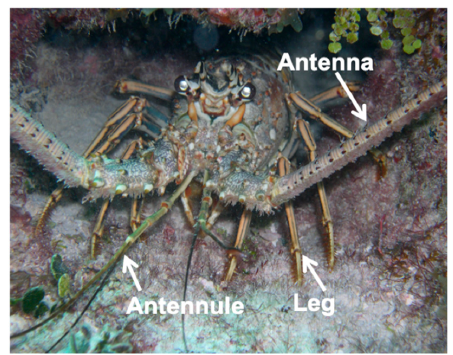
Figure 1. The spiny lobster, Panulirus argus , with anatomy related to search labeled. Antenna are primarily used for mechanosensing, while antennules and legs possess high concentrations of sensilla with both chemosensors and mechanosensors.